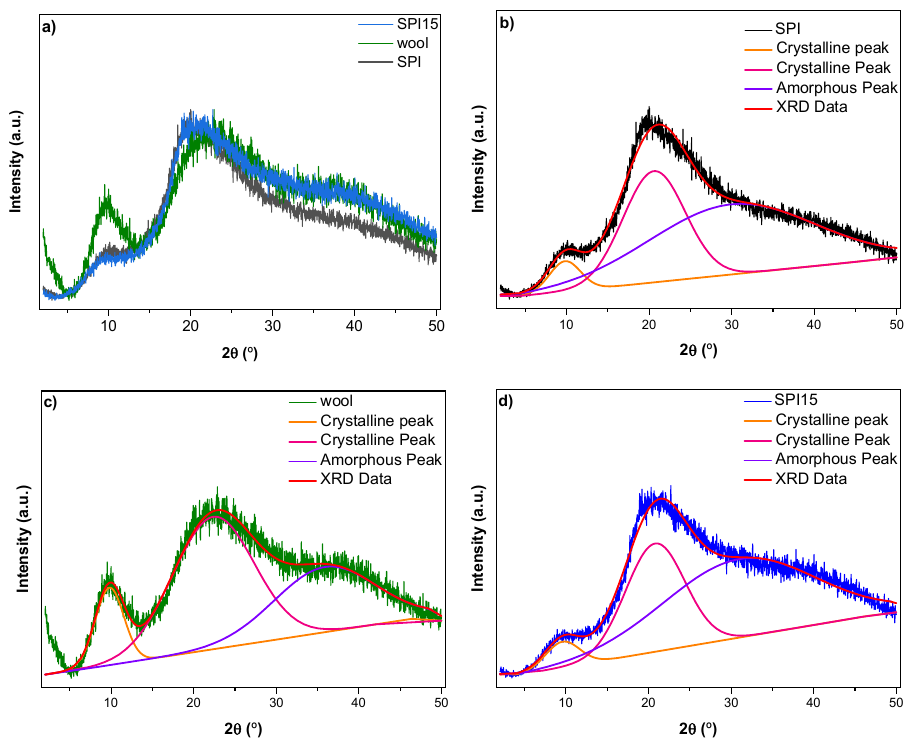
Figure 6. X-ray diffraction patterns of ( a ) SPI, wool, and SPI15, as well as deconvoluted peaks for ( b ) SPI, ( c ) wool, and ( d ) SPI15.